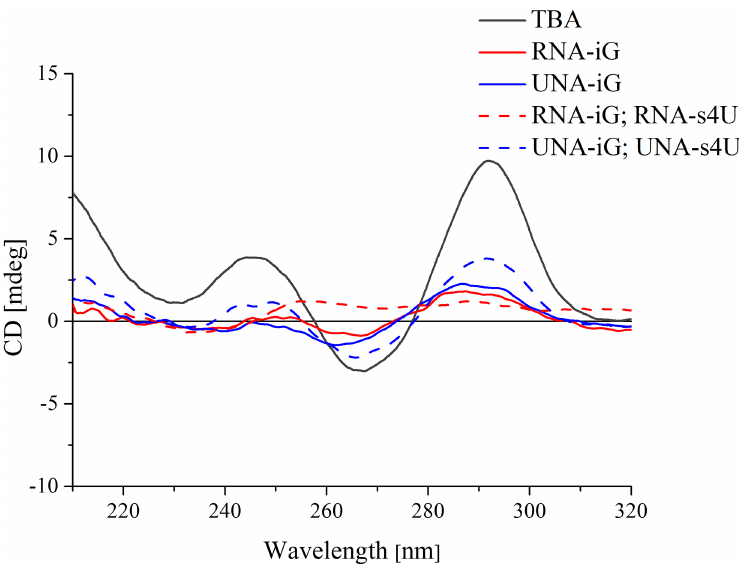
(blue, dashed line).